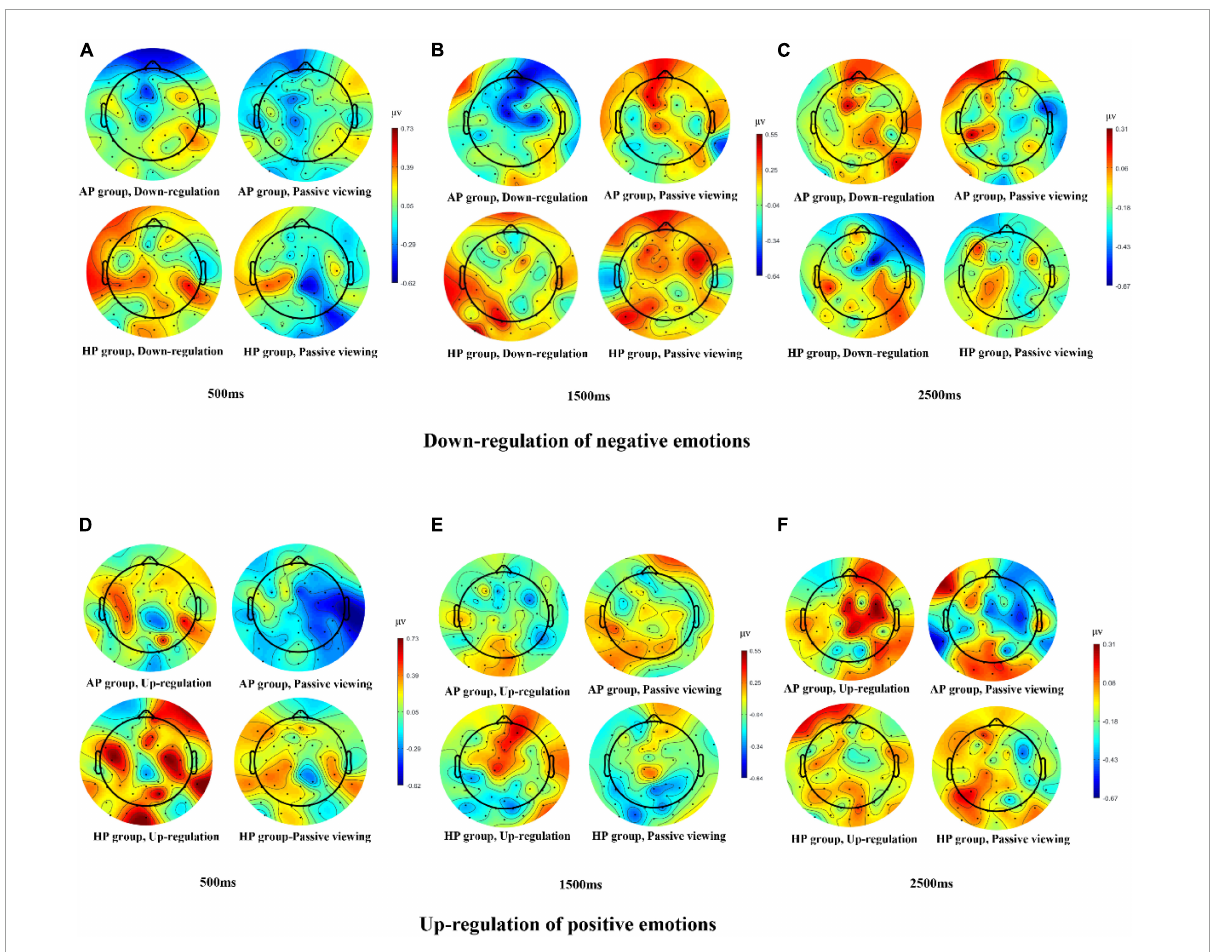
FIGURE6 The topographic maps of LPP amplitudes for different conditions. (A–C) Topographic maps of LPP amplitudes for down-regulation and passive viewing conditions in AP and HP groups at 500 ms, 1500 ms, and 2500 ms, respectively. (D–F) Topographic maps of LPP amplitudes for up-regulation and passive viewing conditions in AP and HP groups at 500 ms, 1500 ms, and 2500 ms, respectively.